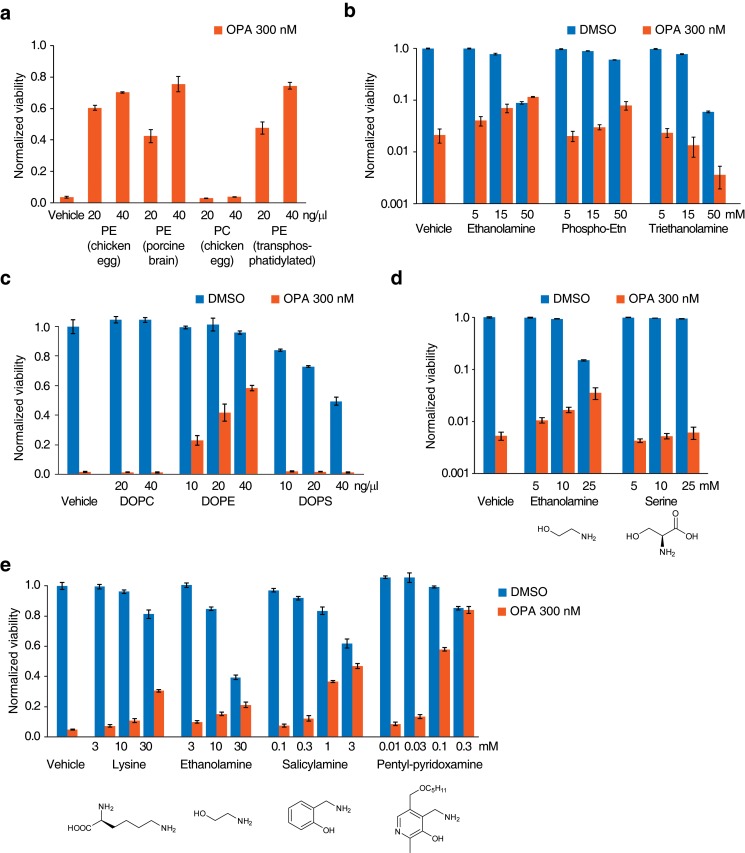
Additional data for ophiobolin A (OPA) inactivation assays with exogenously added small molecules.(a) Commercially available phospholipids (or vehicle) were added at 20 or 40 ng/μL (~25 or 50 μM) to the growth medium of HEK293T cells. Cells were subsequently treated with OPA (or DMSO vehicle) for 72 hr and cell viability was then quantified using a luciferase-based assay measuring ATP content. The viability of vehicle-treated cells in the absence of OPA was normalized to 1. For clarity, only cell viability data in the presence of OPA are displayed. (b) Full plots of the data displayed in Figure 3b. The viability of vehicle-treated cells in the absence of OPA was normalized to 1.0. (c) Assay performed as in (a) using synthetic DOPC (dioleoyl-PC), DOPE (dioleoyl-PE), and DOPS (dioleoyl-PS). (d) Assay performed as in Figure 3b, but using ethanolamine and serine. (e) OPA inactivation assays with 1,4-dicarbonyl scavengers, lysine, and ethanolamine. Assays were performed and displayed in a similar way as in (b) except that the exogenous molecules were preincubated with OPA in phosphate-buffered saline at 5× their final concentration for 2.5 hr before adding to the growth medium of HEK293T cells. (a–e) Results were obtained from assays performed in triplicate and data represent mean values ± standard deviation.